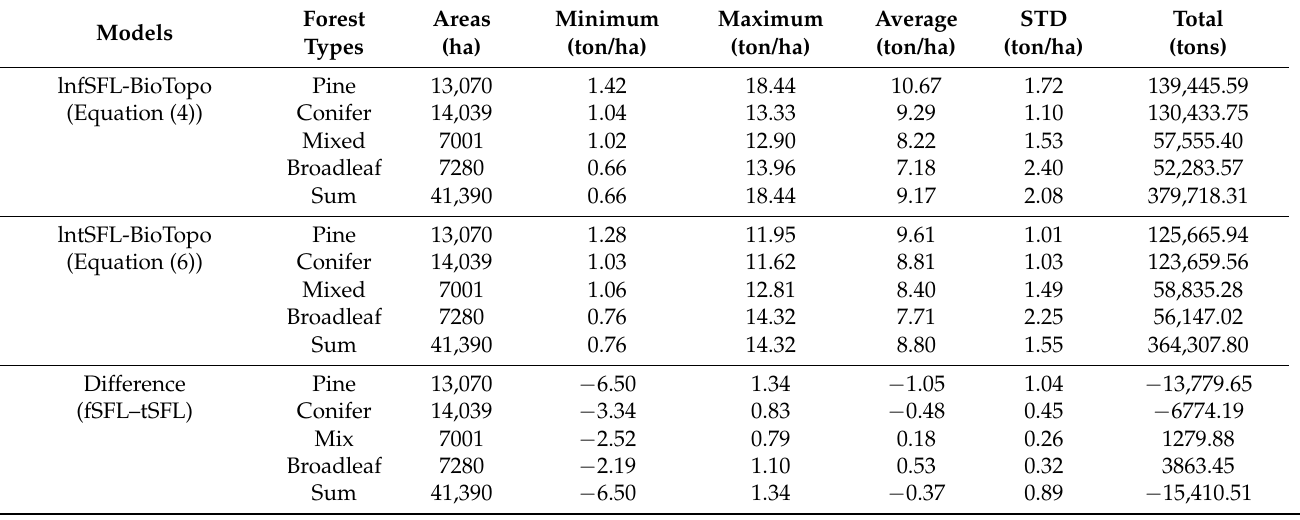
Table 5. A summary of surface fuel loadings with respect to forest types in Dajiaxi National